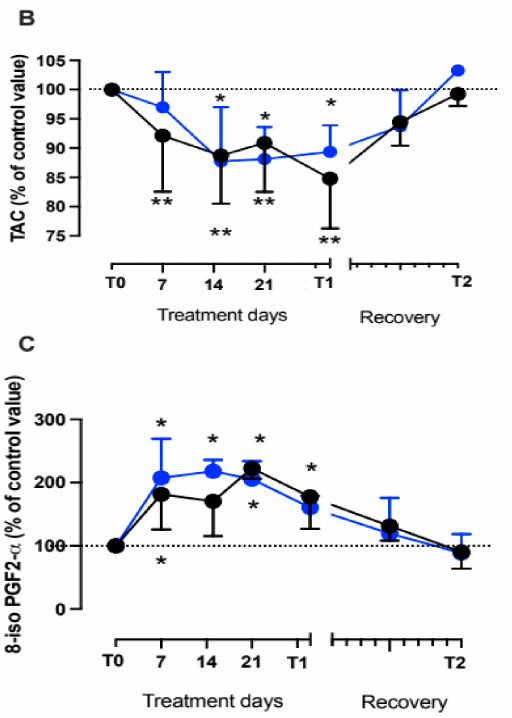
Figure 2. Collected samples during treatments session at 1.5 and 2.5 ATA, and recovery. Time course (% ± SD) of ( A ) Reactive Oxygen Species (ROS) production and ( B ) Total Antioxidant Capacity (TAC) detected on saliva by EPR technique, and ( C ) 8-isoprostane (8-iso PGF2 α ) measured on urine by immune-enzymatic assay. Significant difference intra-group: * p < 0.05; ** p < 0.01; *** p < 0.001, **** p < 0.0001. Significant difference between groups: # p < 0.05.